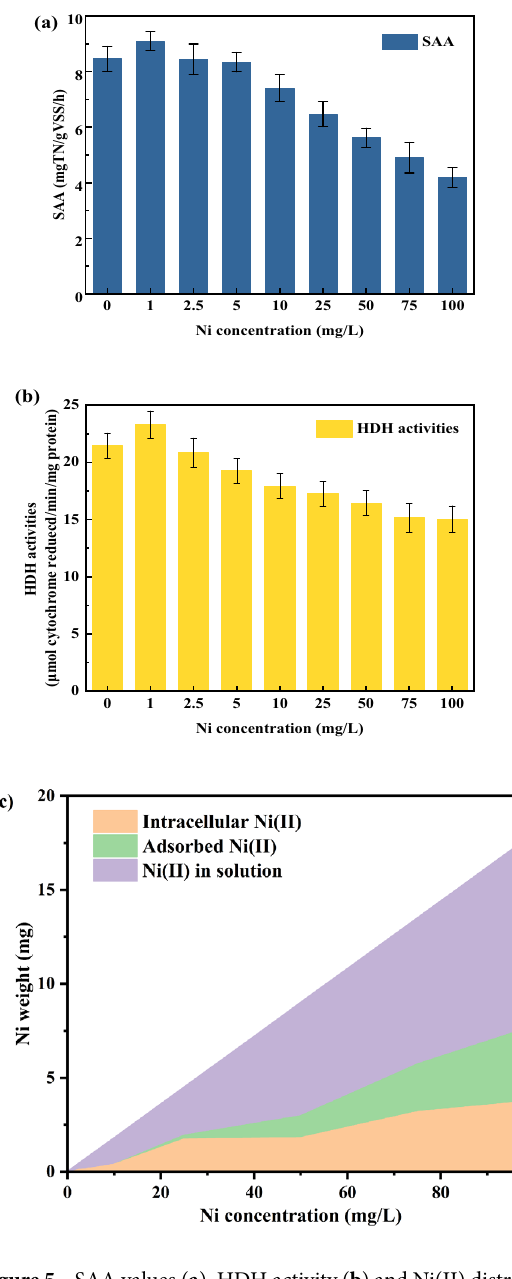
Figure 5. SAA values ( a ), HDH activity ( b ) and Ni(II) distribution in different regions ( c ) in batch experiments with different Ni(II)